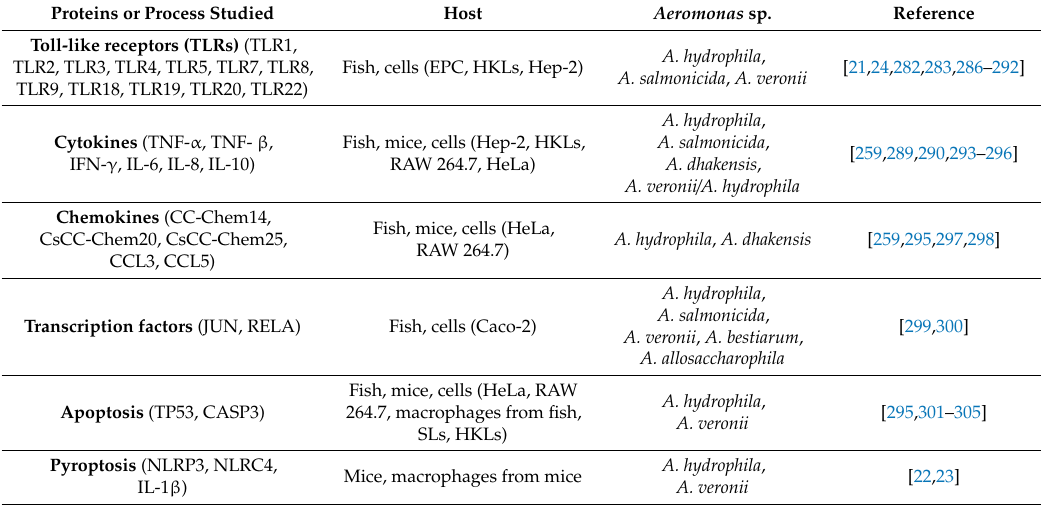
Table 2. Studies (2009–2019) that evaluate proteins and processes involved in the immune response of the animal models or cell line host after Aeromonas spp. (adapted from